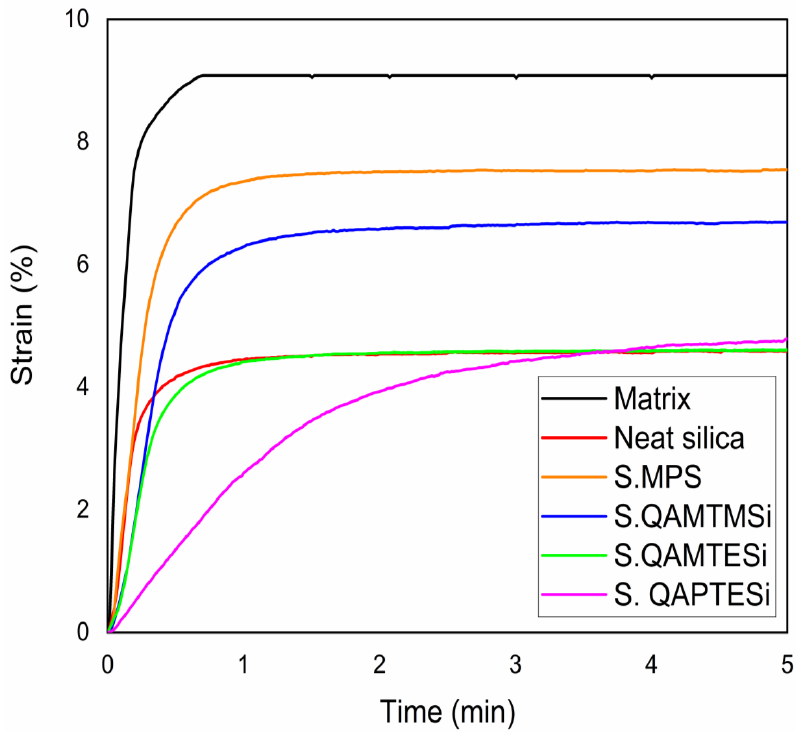
Figure 7. Time dependence of polymerization shrinkage strain of Bis-GMA/TEGDMA matrix and dental nanocomposite resins containing 22 wt% of diverse types of organically modified nanosilica.